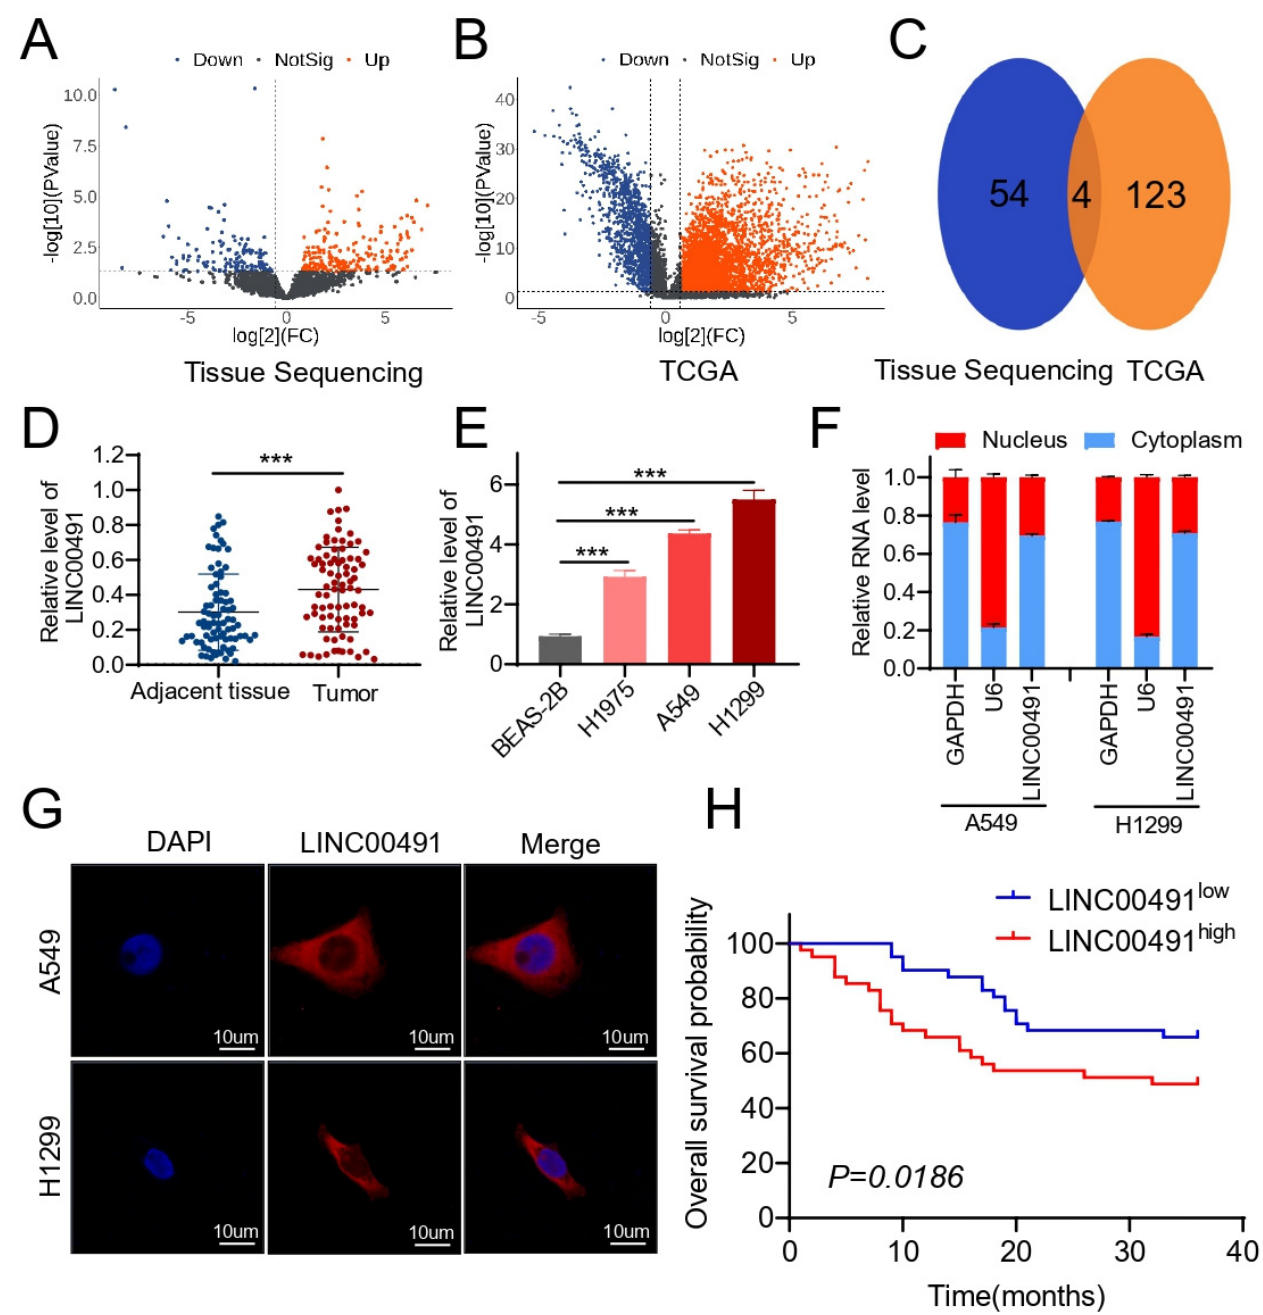
Figure 1. Global analyses of aberrant lncRNAs in LUAD and high-LINC00491 expression in LUAD tissues and cell lines. ( A ) The volcanic plot of lncRNAs between LUAD and match adjacent normal tissues. ( B ) A volcanic plot of lncRNAs between LUAD and normal lung tissues in the TCGA database. ( C ) The common, significantly upregulated lncRNAs between tissue sequencing and the TCGA database in LUAD. ( D ) Detection of the LINC00491 level in the isolated RNA from the cytoplasm and cell nucleus in A549 and H1299 cells using RT-qPCR assays. ( E ) Analysis of LINC00491 expressions in A549, H1299 and H1975 cells relative to that in BEAS-2B cells using RT-qPCR. ( F ) The relative expression of LINC00491 in the cytoplasm and nucleus using RT-qPCR assays. ( G ) Localization of LINC00491 using FISH assay in A549 and H1299 cells. Scale bar = 10 µ m. ( H ) The log-rank test of the impact of the LINC00491 expression level on the survival of patients with LUAD. In each experiment, three replicates were conducted. Data are presented as the mean ± SD. ***, p <